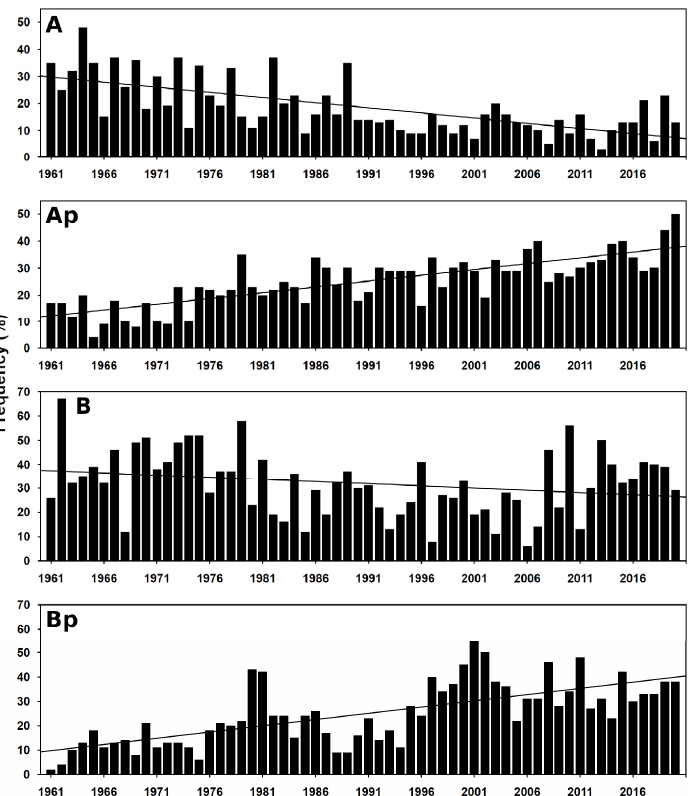
Figure 14. Fluctuations in the occurrence frequencies of the CHMI types ( A ) (anticyclone over Central Europe), ( Ap ) (travelling anticyclone), ( B ) (trough over Central Europe), and ( Bp ) (travelling trough) and their linear trends during the 1961–2020 period.